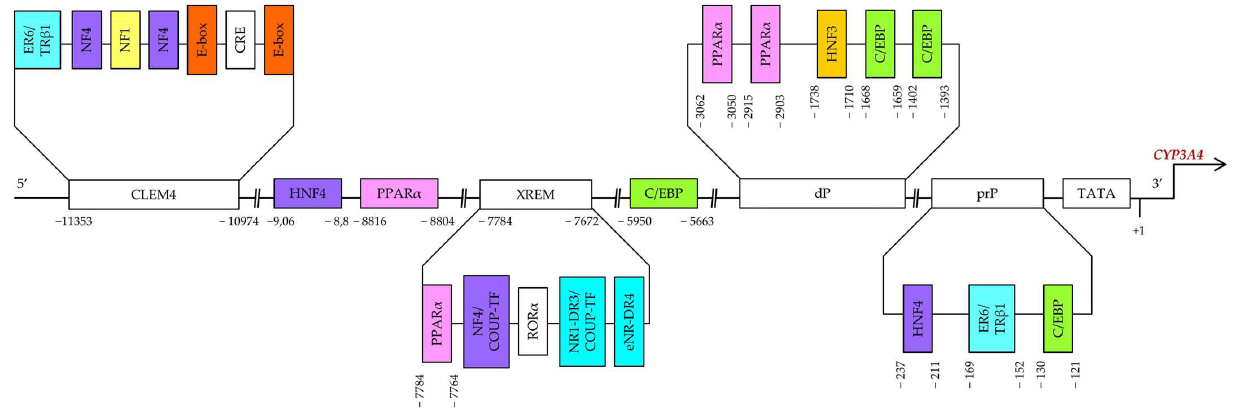
Figure 2. Binding sites in the upstream part of CYP3A4 . prP: proximal promoter, dP: distal promoter, XREM: a distal element called xenobiotic-responsive enhancer module, CLEM4: a distal element called constitutive liver enhancer module 4.